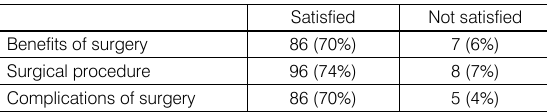
Table 3. Degree of satisfaction with explanation of